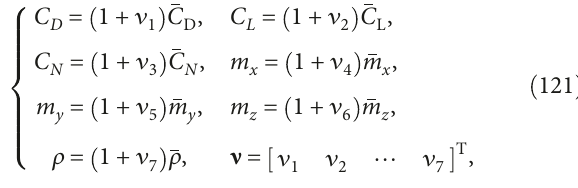
Figure 14: Curves representing the fi n de fl ections. Inva_sp: invariable span; Va-sp: variable span.